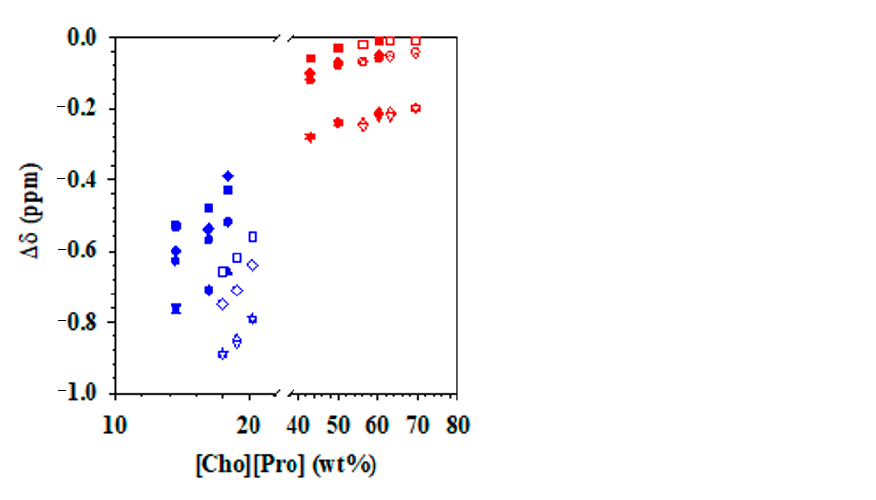
Figure 4. Chemical shift deviations of the protons in the top, [Cho][Pro]-rich phase (red) and the bottom, K 3 PO 4 -rich phase (blue) of the ABS with [Cho][Pro] and K 3 PO 4 at pH 7.2 (filled symbols) and pH 14.5 (open symbols): H1 ( ◆ ), H2( ▼ ), H3( ▲ ), H4 ( ■ ), H5( ● ), following the numeration in- dicated in Figure 3.